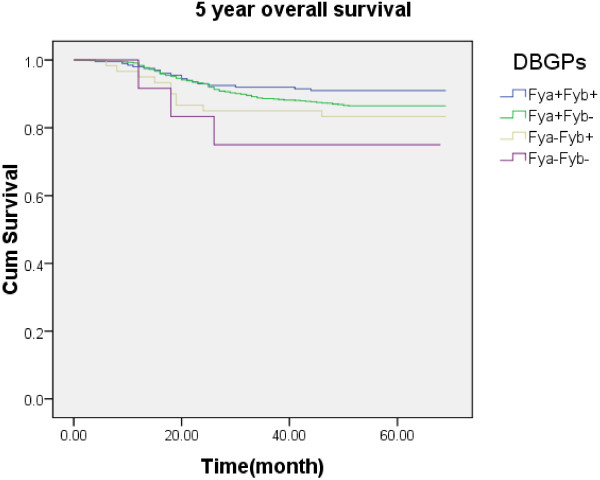
The 5 year overall survival curves indicated a statistical significance (p = 0.02) of the overall survival difference between patients with difference phenotypes. The 5 year overall survival distribution was 91.0% in Fya + Fyb+, 86.5% in Fya + Fyb-, 83.3% in Fya-Fyb + and 75.0% in Fya-Fyb-.